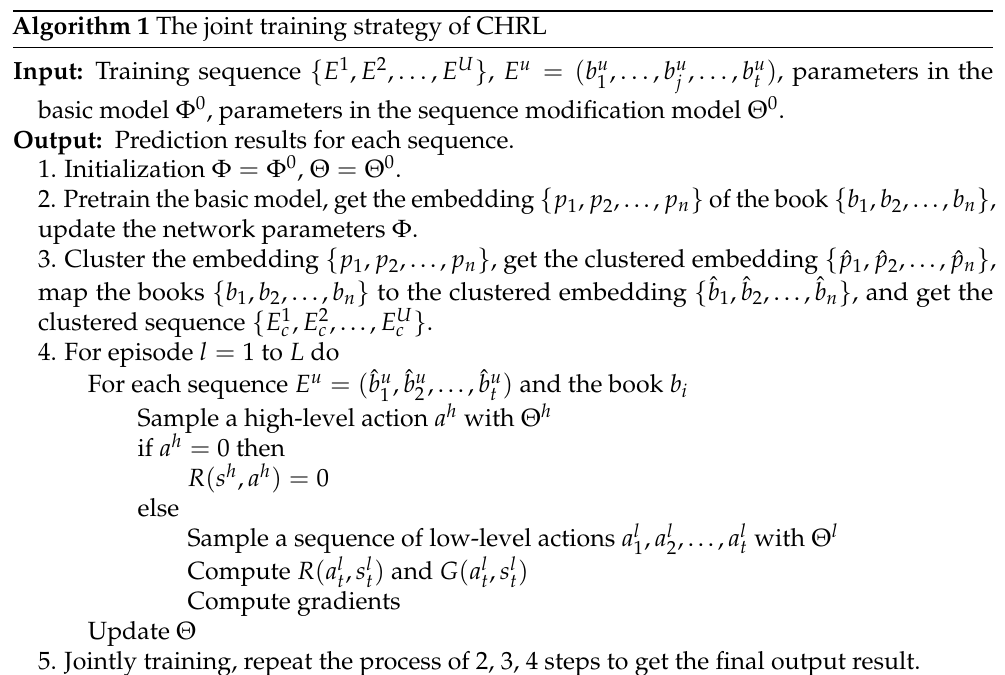
Algorithm 1 The joint training strategy of